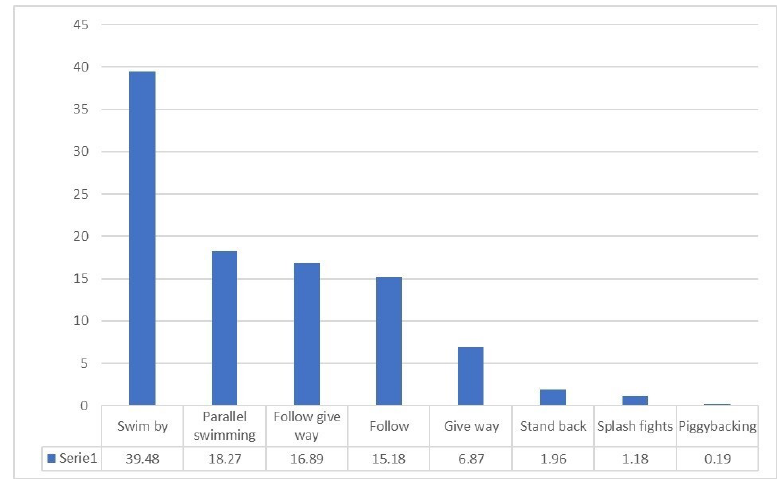
Figure 5. Percentage frequencies of social behavior modules observed between 2009 and 2018 in white sharks ( Carcharodon carcharias ).